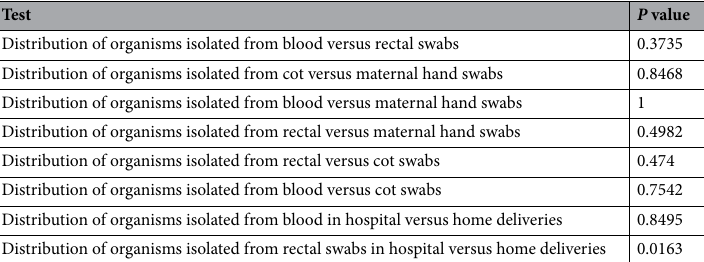
Table 3. Comparison of species distributions of organisms isolated from blood, rectal, cot and maternal hands, using a Kolmogorov–Smirnov tests. As eight tests were conducted, the threshold for significance after the Bonferroni correction was 0.05/8 = 0.00625.